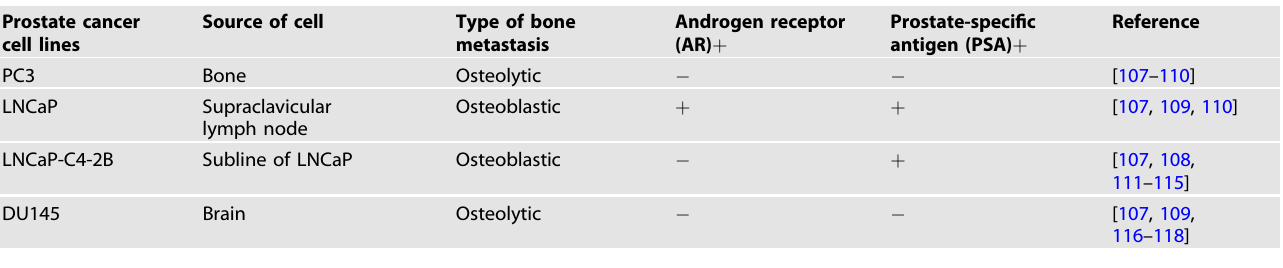
Table 2. Commonly used cell lines in the translational models of prostate cancer. Prostate cancer cell lines